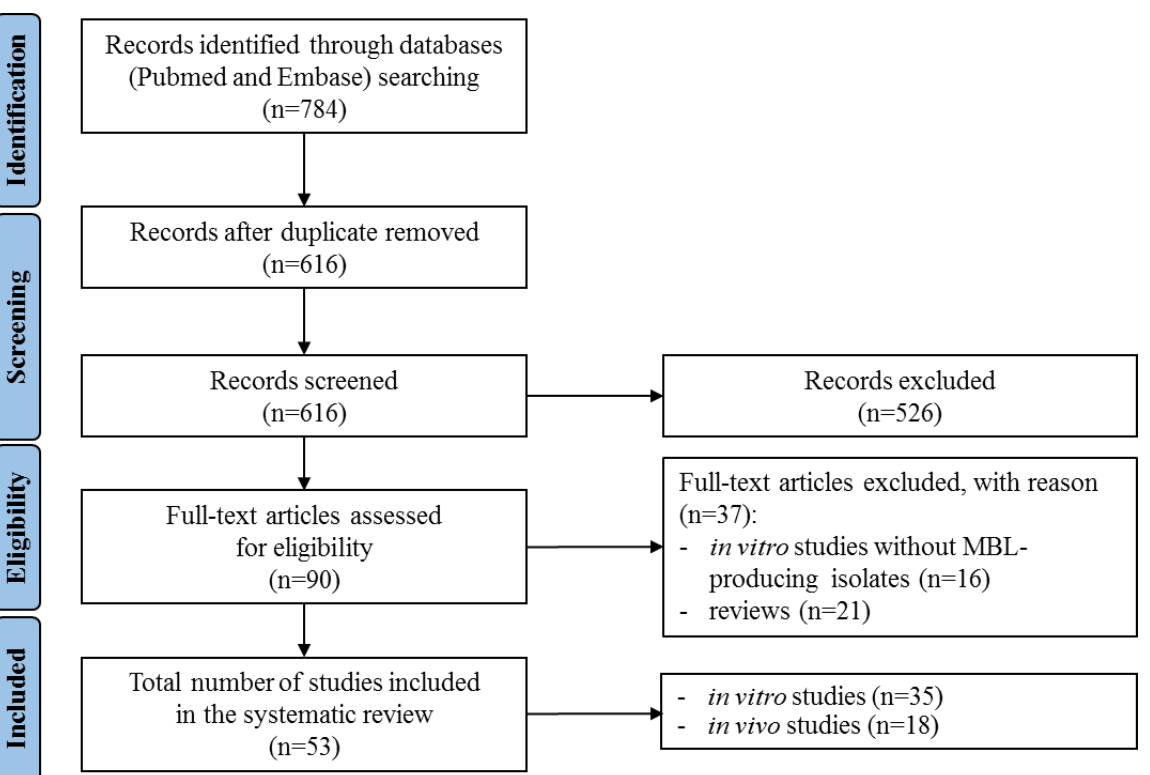
Figure 2. Literature search strategy.